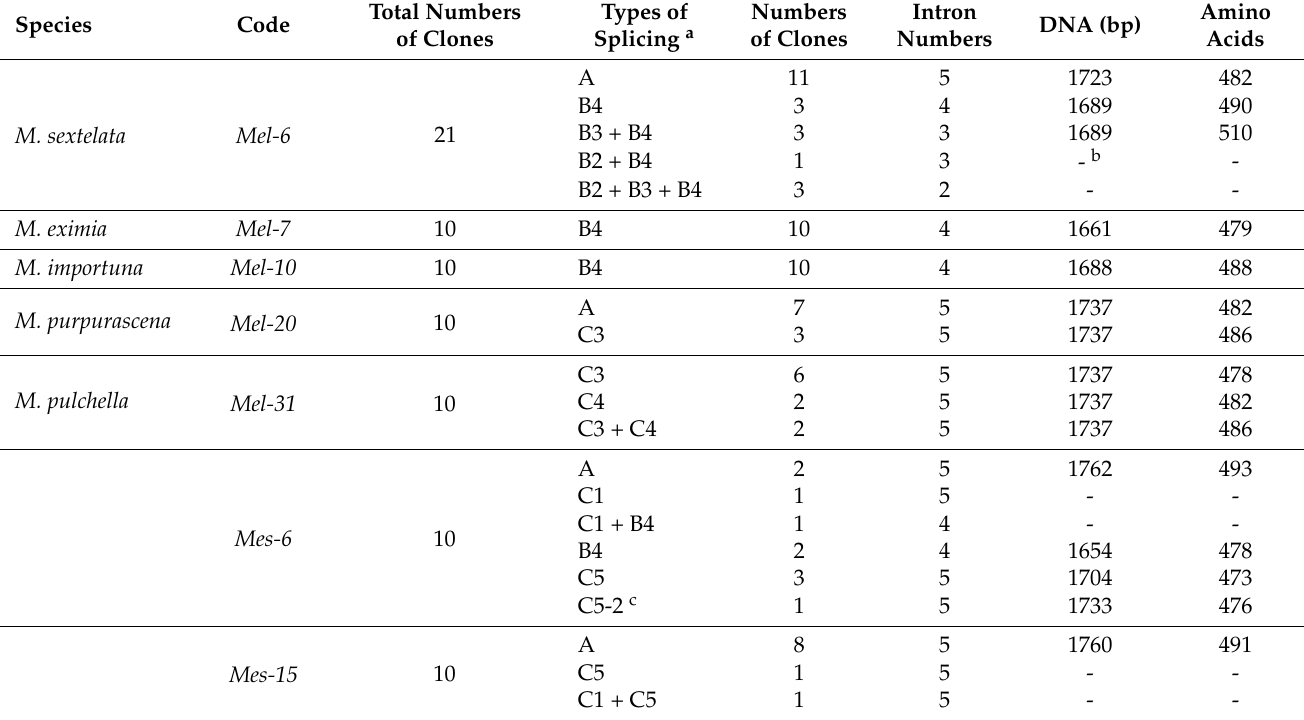
Table 4. The types of alternative splicing in the MAT1-1-10